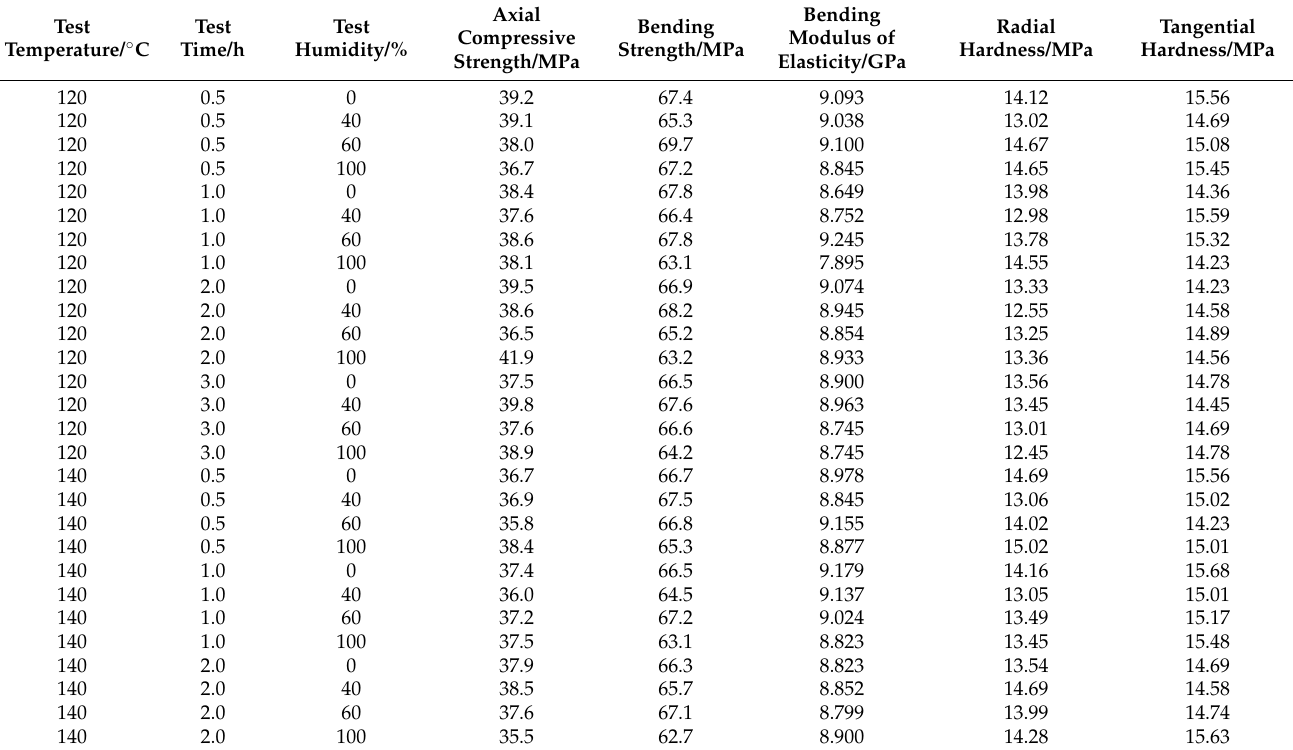
Table A1. Wood treatment conditions and corresponding mechanical